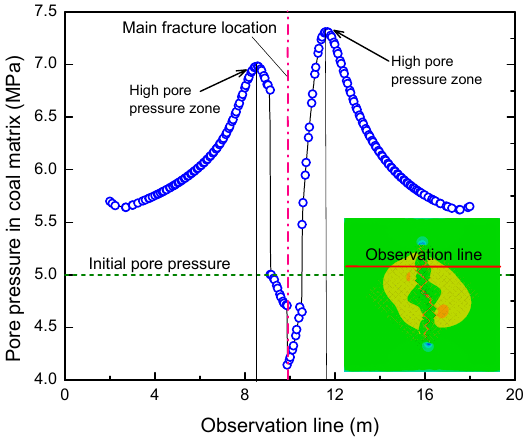
Figure 13. The pore pressure distribution along the observation line.